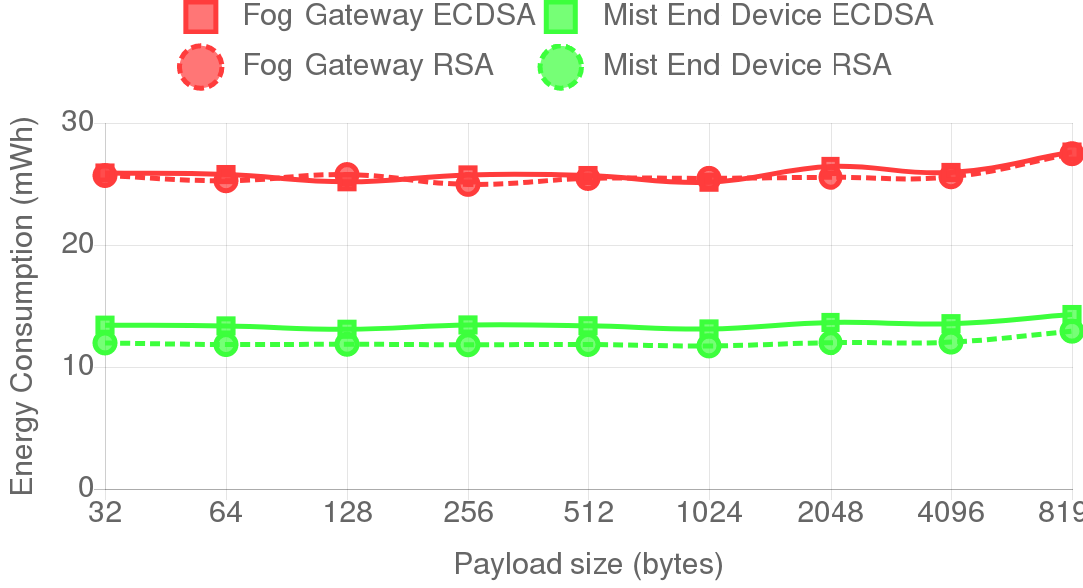
Figure 6. Energy consumption for all the tested payloads when using a 1024-bit RSA key and a secp192k1